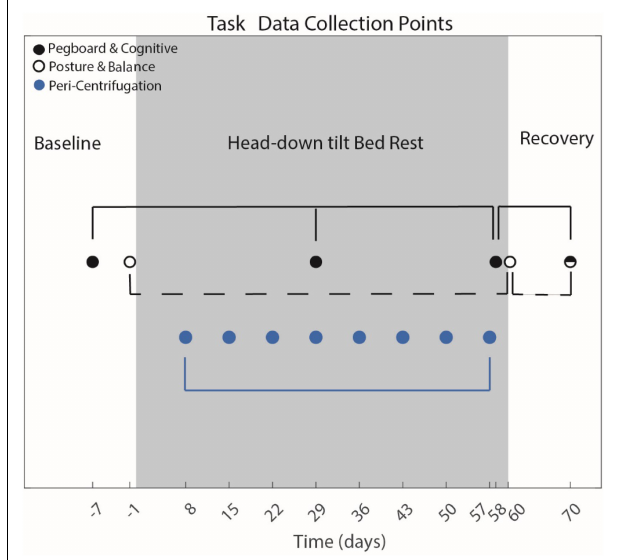
FIGURE 1 | Testing Timeline. Entering head-down tilt bed rest ( HDBR ) occurred on day 0. Cognitive and sensorimotor measures were collected at various points before, during and following HDBR. Peri-centrifugation tasks only occurred during HDBR. Filled black dots represent data collection time points for the Purdue Pegboard and cognitive assessments. The open filled black circles represent the data collection time points of the posture and balance tasks. The half-filled dot indicates that all sensorimotor and cognitive assessments were collected at that time. The blue dots represent the peri-centrifugation task collections. The day relative to entering HDBR upon which the data were collected is plotted. Only data collection time points used for statistical analysis are included in this